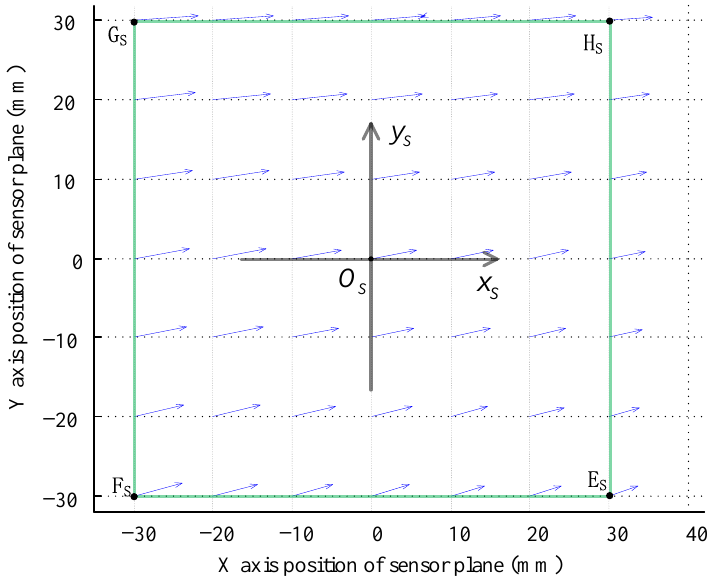
Figure 6. Image motion ’s linear velocity distribution on the sensor plane.